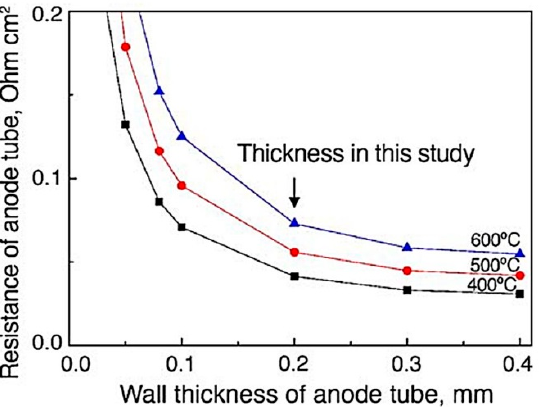
Figure 19. Wall thickness versus area-specific resistance for 12 mm long 0.8 mm OD tube